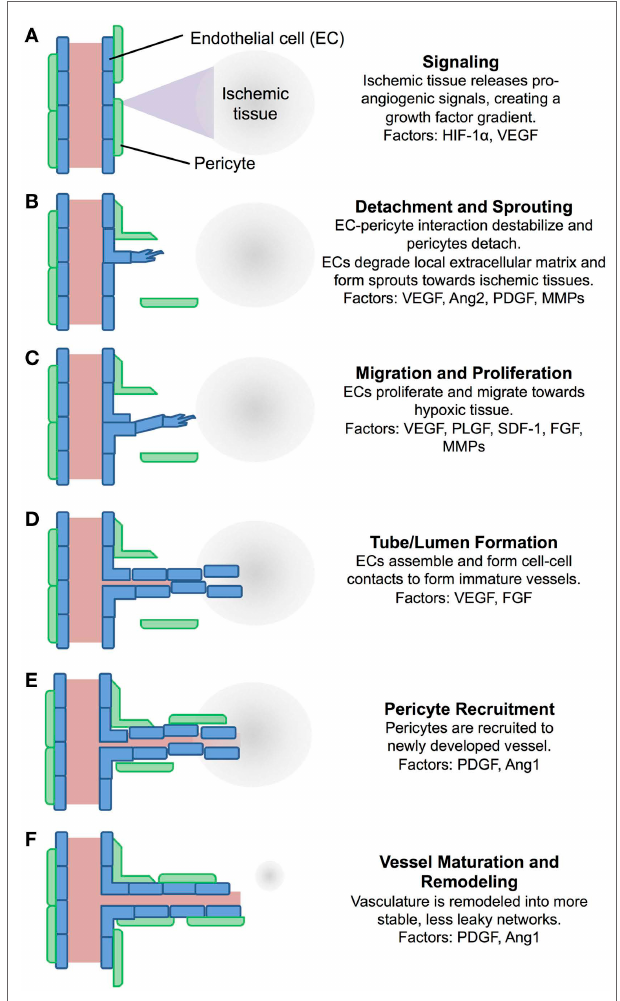
FiGURe 1 | A schematic of the process of angiogenesis . Angiogenesis is a process tightly controlled by a number of factors. (A) Ischemic tissue release pro-angiogenic signals, which diffuse into nearby tissue. (B) Pericytes detach from nearby vessels, and ECs form sprouts. (C) ECs proliferate and migrate towards the signal gradient. (D) ECs align into immature vessels. (e) Pericytes are recruited to the new vessels. (F) Vasculature is remodeled and stabilized. Many of the factors involved in this process have been exploited for pharmacological intervention, either supplementing them for pro-angiogenic applications, or inhibiting them for anti-angiogenic applications. EC, endothelial cell; HIF-1 α , hypoxia-inducible factor-1 α ; VEGF, vascular endothelial growth factor; Ang2, angiopoietin 2; PDGF, platelet-derived growth factor; MMPs, matrix metalloproteinases; PLGF, placenta growth factor; SDF-1, stromal cell-derived factor-1; FGF, fibroblast growth factor; Ang1, angiopoietin 1 (Ziche et al., 2004; Hirota and Semenza, 2006; Adams and Alitalo, 2007; Lieu et al., 2011; Chu and Wang, 2012; Brudno et al.,